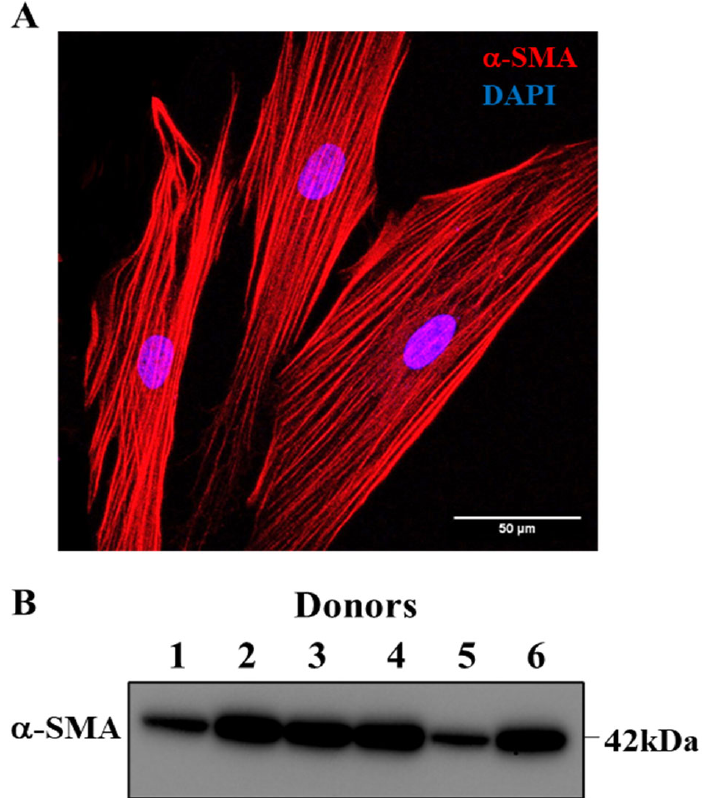
Figure 2. Confirmation of hASM phenotype. ( A ). Representative maximum intensity Z projection image of hASM cells displaying immunoreactivity for alpha-smooth muscle actin ( α -SMA) expression, which was used to confirm hASM phenotype. Note that α -SMA immunoreactive hASM cells were larger and displayed a fusiform shape (scale bar= 50 µ m). ( B ). Western blot confirming the expression of α -SMA in bronchiolar sample homogenates. Only those bronchiolar samples displaying α -SMA expression were used for biochemical/molecular biology analyses.